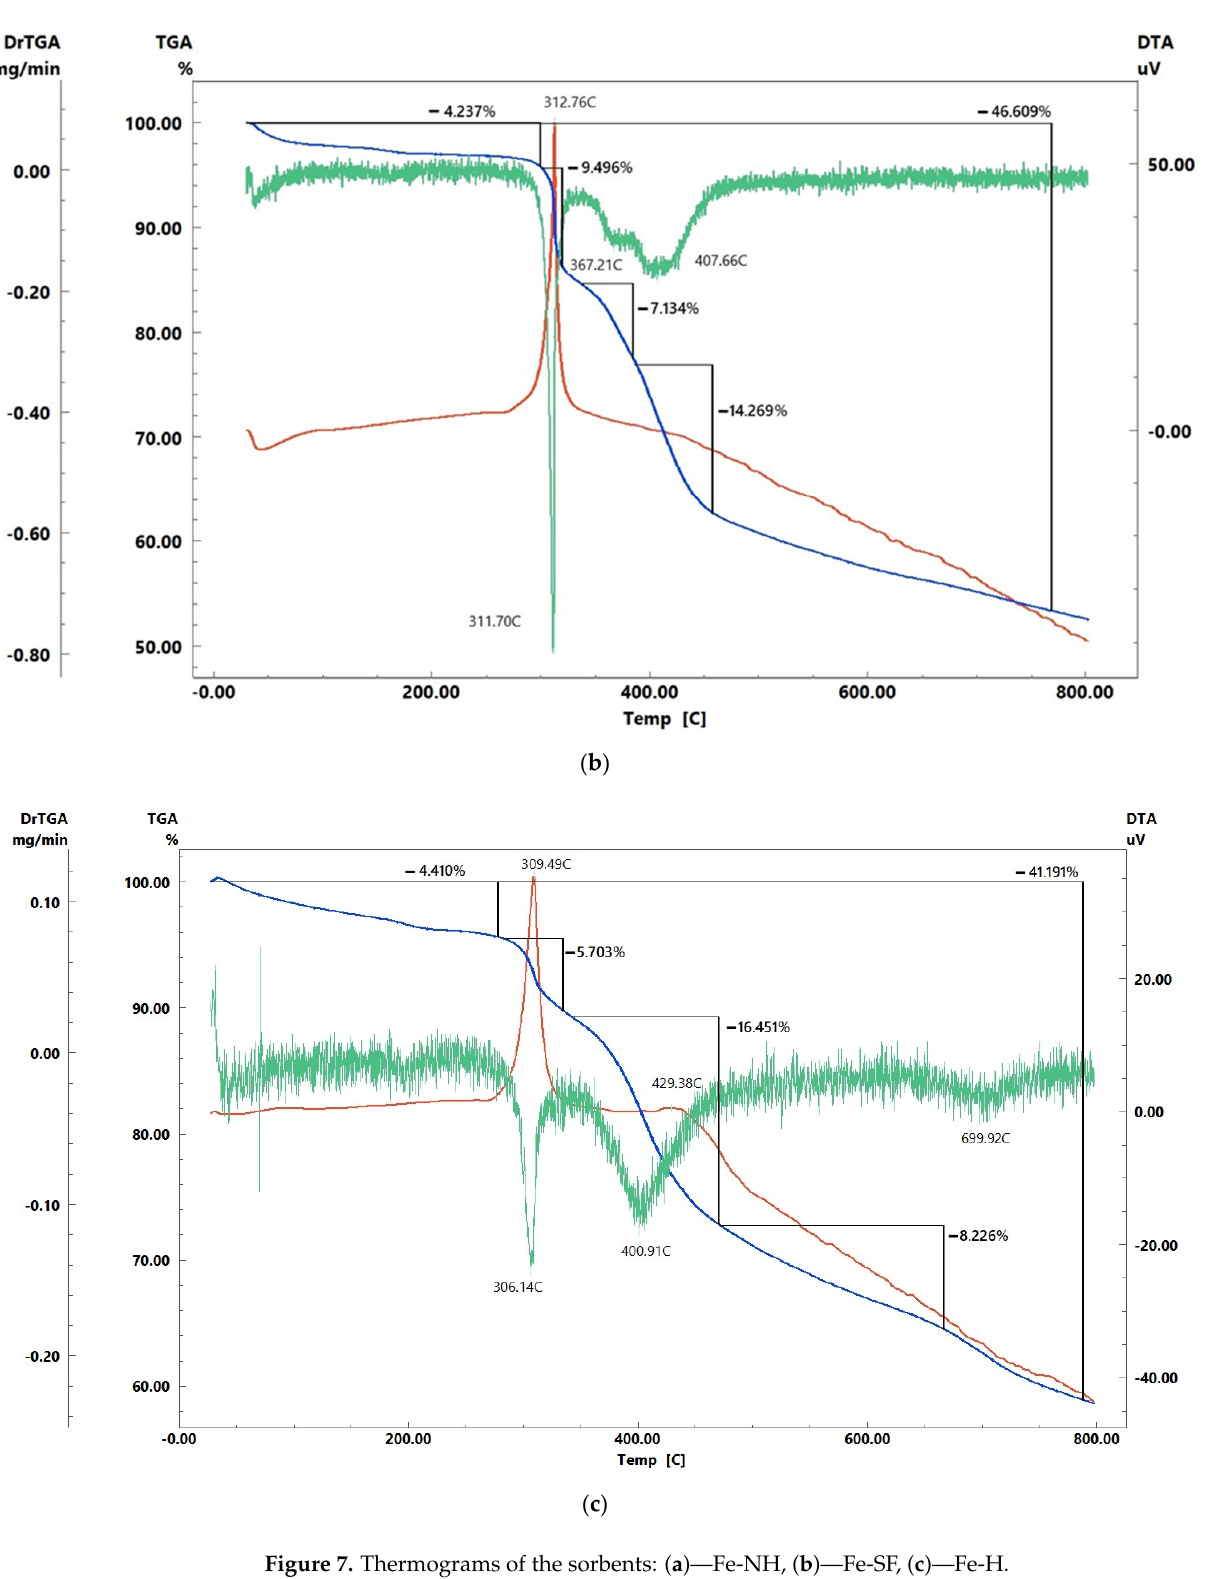
Figure 7. Thermograms of the sorbents: ( a )—Fe-NH, ( b )—Fe-SF, ( c )—Fe-H.